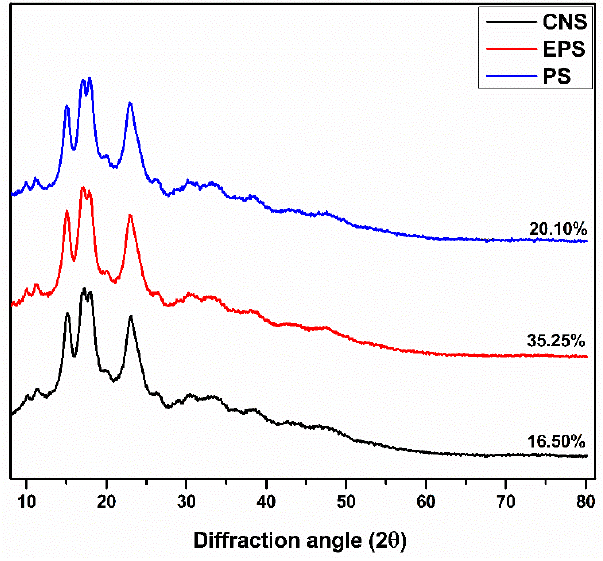
Figure 5. X-ray diffractogram of untreated and CLSs.